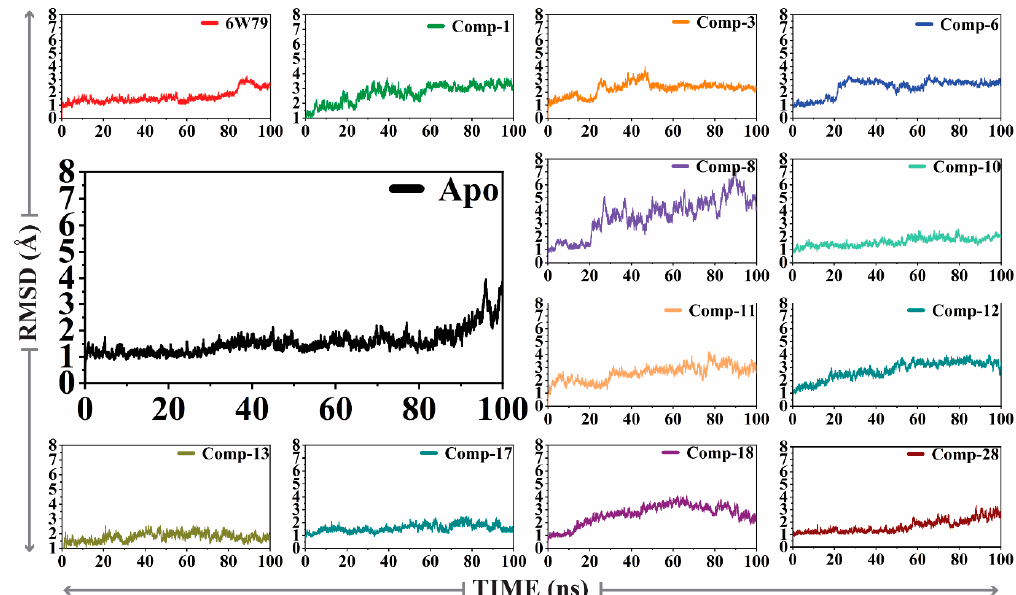
Figure 2. The RMSD plots of apo–M pro and ligand-bound form of M pro . The average RMSD of apo–M pro and inhibited M pro was 2.8 Å and <3.9 Å, respectively.